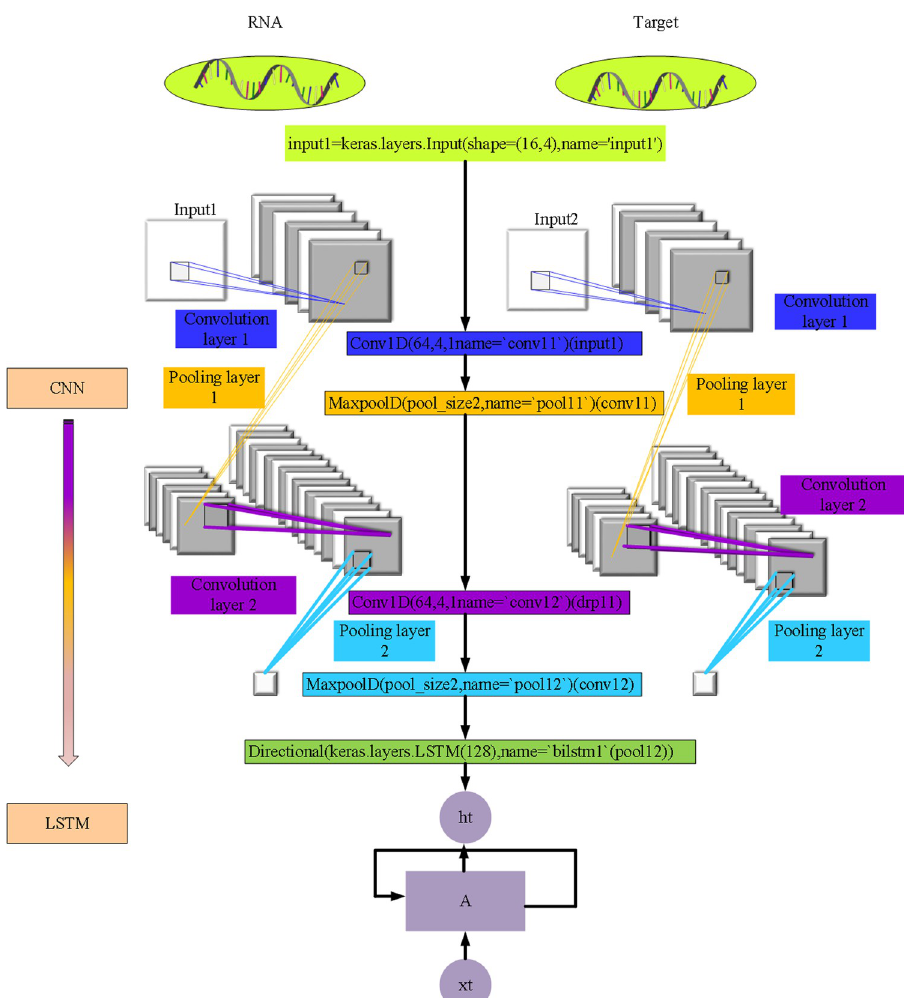
Fig 8. Algorithm flow of the CNN + LSTM